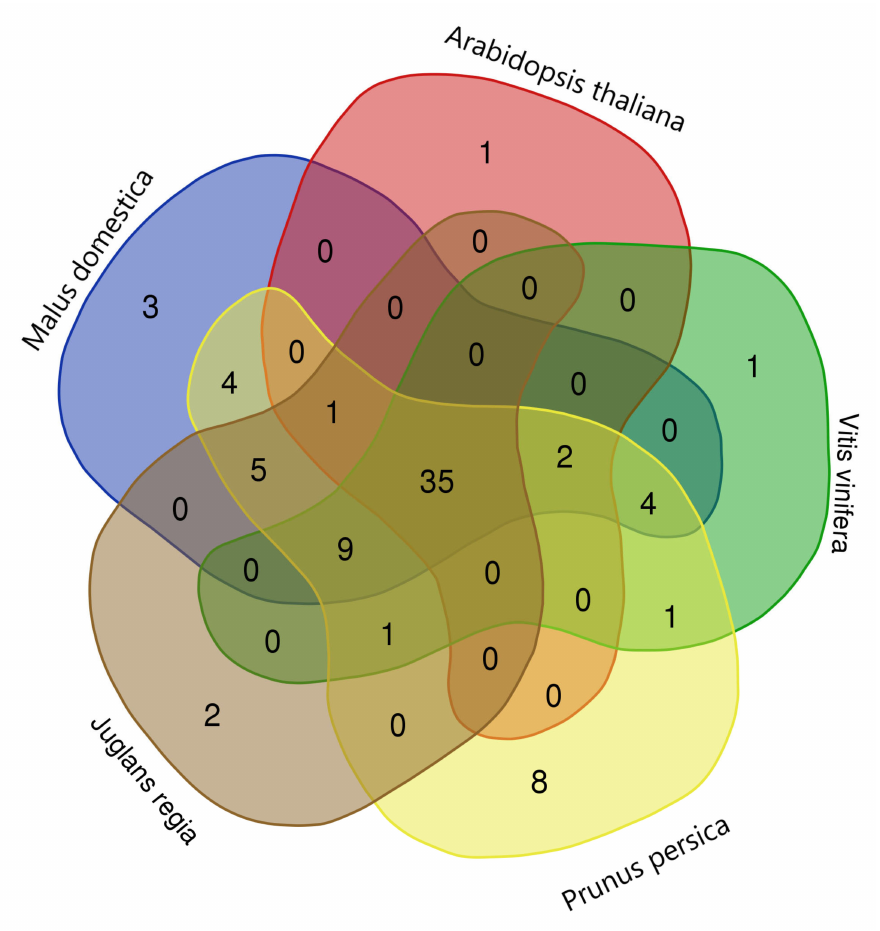
Figure 8. Venn diagram of syntenic analysis. The diagram shows the unique and common PdNAC having synteny with A. thaliana , P. persica , J. regia , V. vinifera and M. domestica